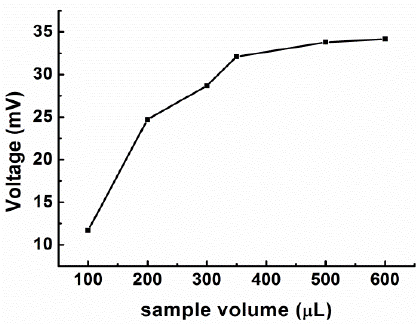
Figure 2. Effect of sample volume of a 93.75 mg/L glucose solution on the response of the FIA biosensor at a flow rate of 1.0